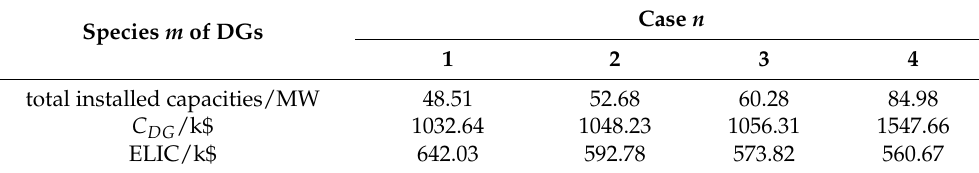
Table 4. The value indexes for optimal sizing and siting of DGs in case n